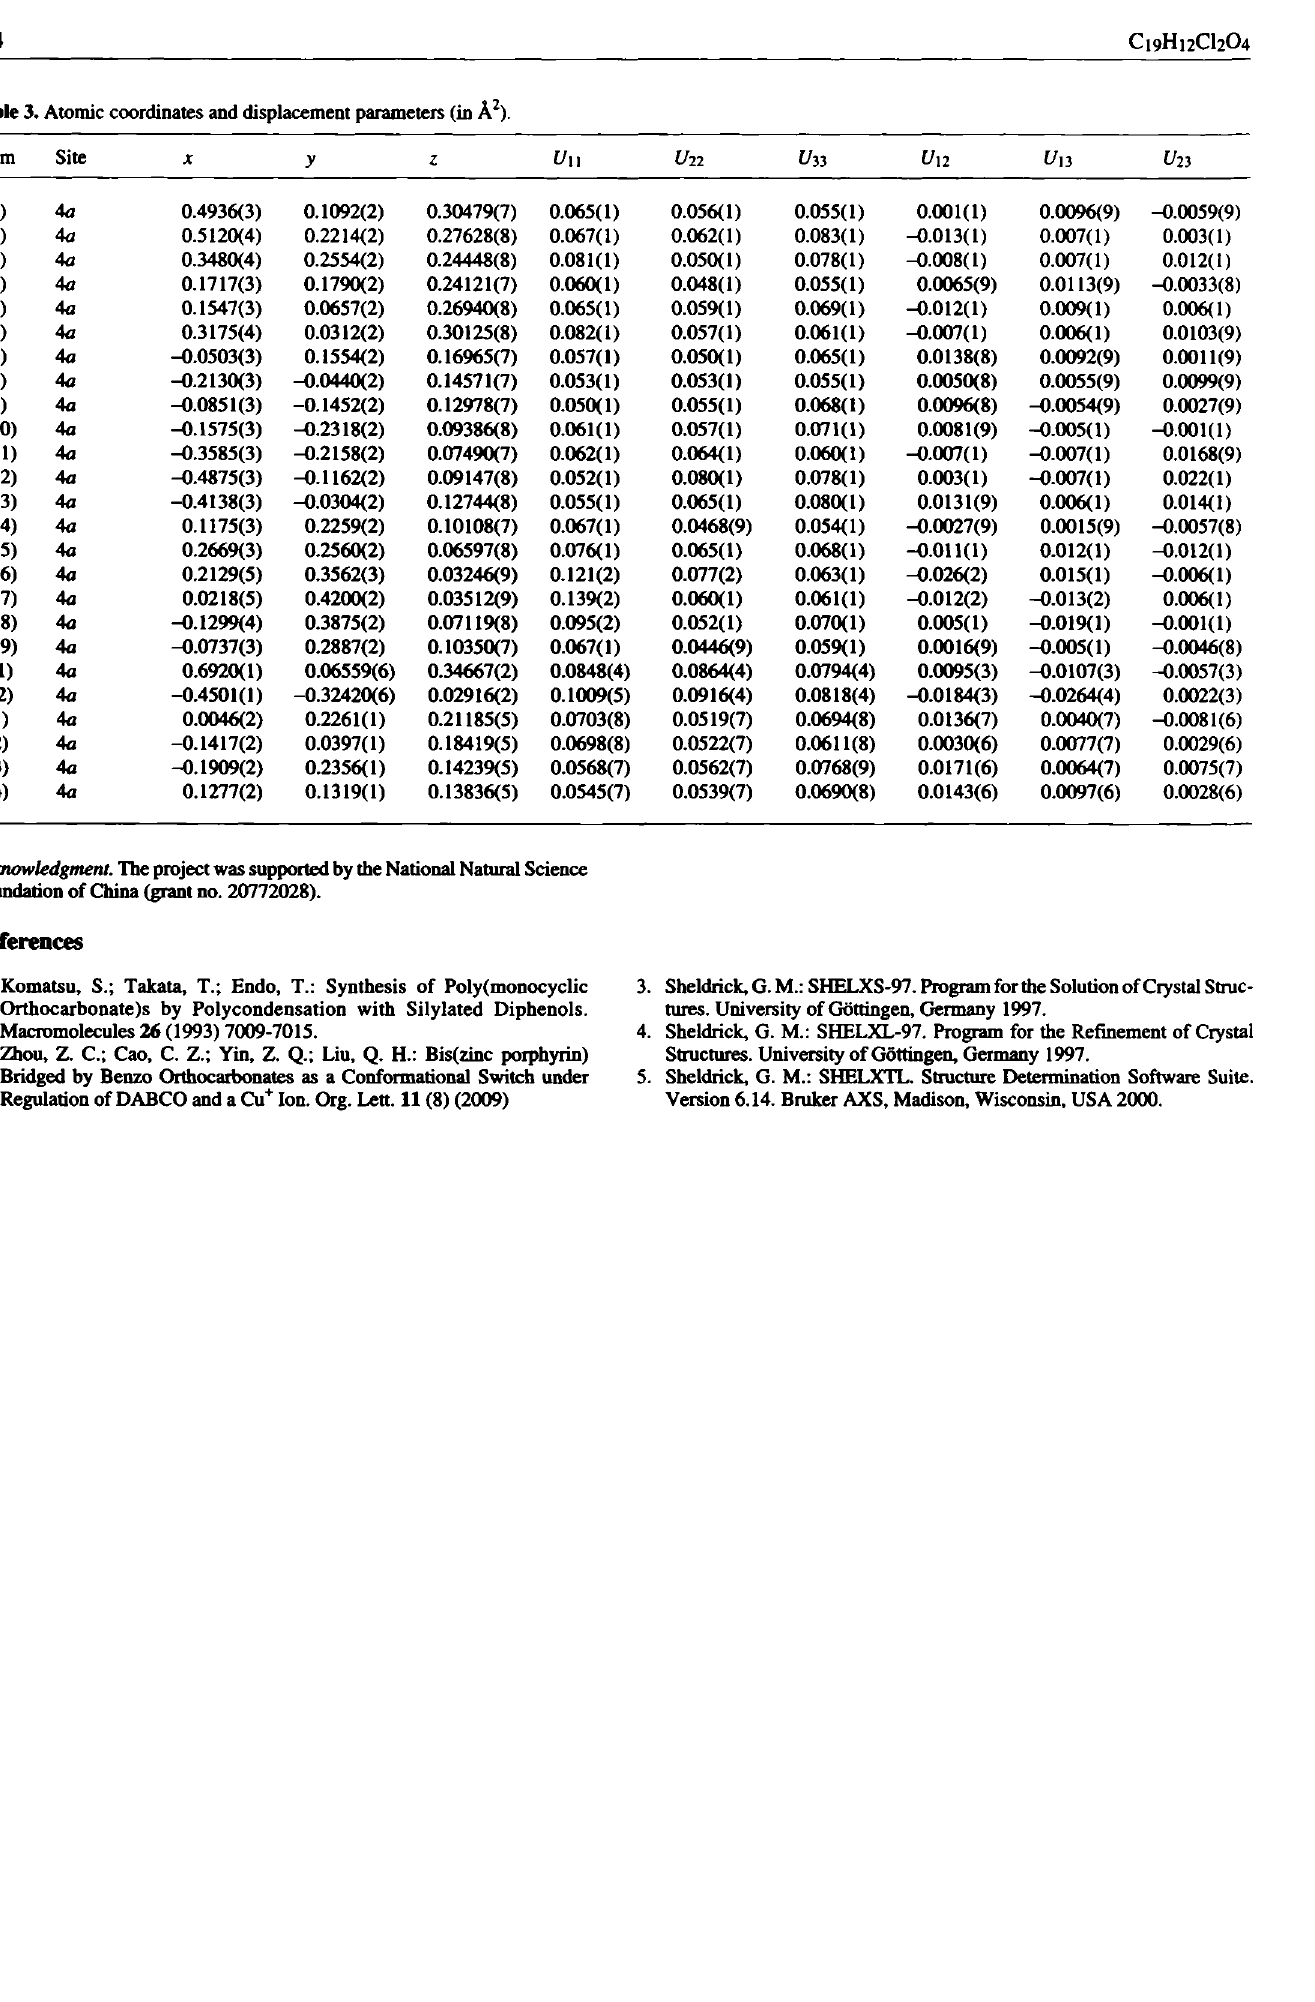
Table 3. Atomic coordinates and displacement parameters (in Â 2